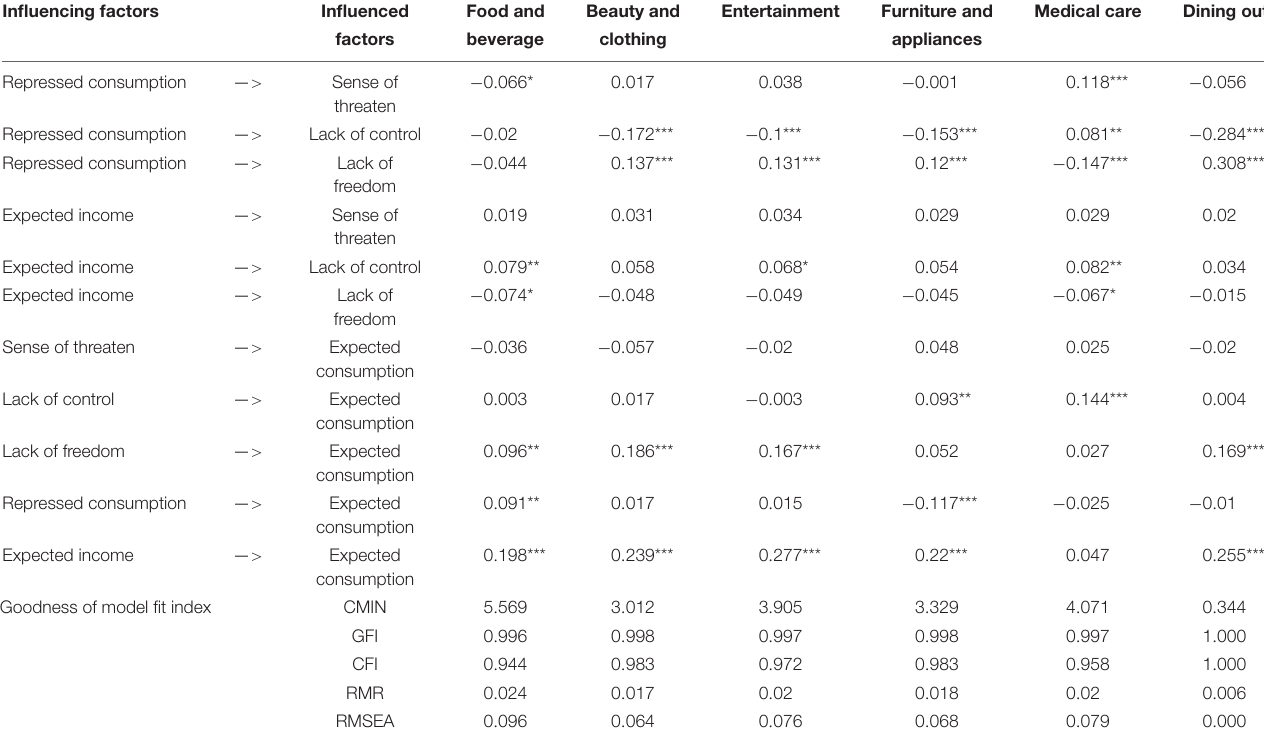
TABLE 2 | The empirical results of SEM models concerning different product categories. Influencing factors